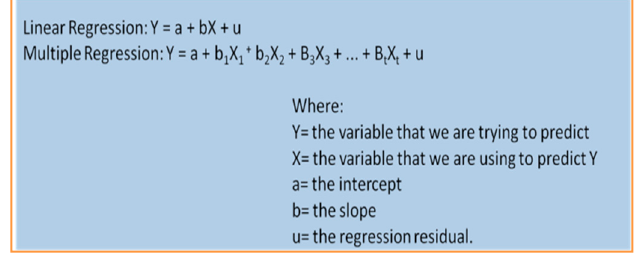
Figure 13. Types of regression.